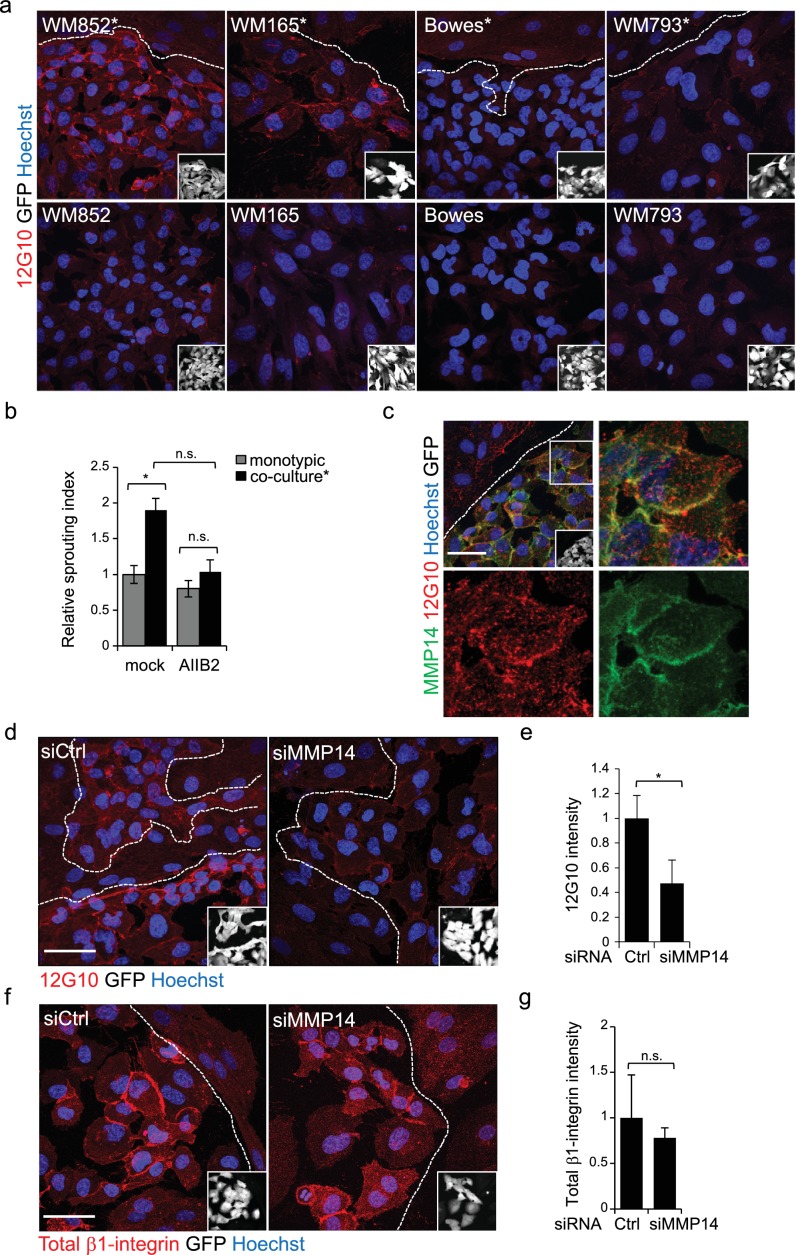
Change in the 3D growth phenotype of the LEC primed melanoma cells is β1-integrin dependent.(a) Representative confocal images of active β1-integrin (12G10) staining (red) in the indicated melanoma cell lines (GFP positive cells (white) in the inset) in the presence (*, upper panels) or absence (bottom panels) of LECs. Nuclei were counterstained with Hoechst 33342. The dashed line indicates the LEC-melanoma border. Scale bar = 50 µm. (b) Quantification of 3D sprouting index in WM852 and WM852* mock treated or treated with β1-integrin blocking antibody (AIIB2) during the 96 hr fibrin growth assay. Graph shows the average of at least three images per condition per two independent experiments, error bars indicate the SEM; *: p<0.05. n.s., non-significant. (c) Representative confocal image of active β1-integrin (12G10, red) and MMP14 (green) staining of WM852* (white cells in the inset). Nuclei were counterstained with Hoechst 33342. The dashed lines indicate the border between LEC and WM852 (white, GFP positive WM852 cells in the inset). The right and bottom panels show an enlargement of the area enclosed within the white square as a merge, Notch3 (red) and MMP14 (green) in separated channels. Scale bar = 50 µm. (d,f) Representative confocal images of WM852* treated with the indicated siRNAs for 72 hr and stained for active β1-integrin with 12G10 (d, red), or total β1-integrin with P5D2 (f, red) antibodies. Nuclei were counterstained with Hoechst 33342. The dashed lines indicate the LEC-WM852 borders (white, GFP positive WM852 cells in the inset) border. Scale bar = 50 µm. Quantification of the average 12G10 (e) and total β1-integrin (g) signal intensity in WM852* (white) cells. Four images/condition were quantified from two independent experiments. More than 100 cells were always analysed per condition; error bars indicate SD. *: p<0.05. n.s., non-significant. Full size confocal images are available as a source data 3.